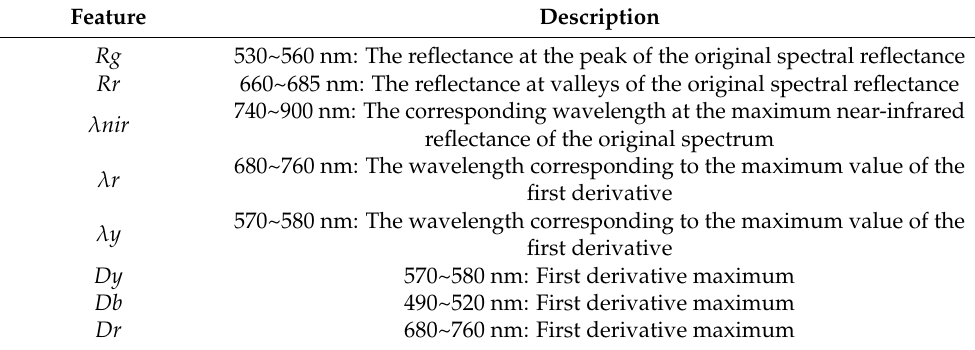
Table 2. The hyperspectral